Question: Summarize what this figure shows in one sentence.
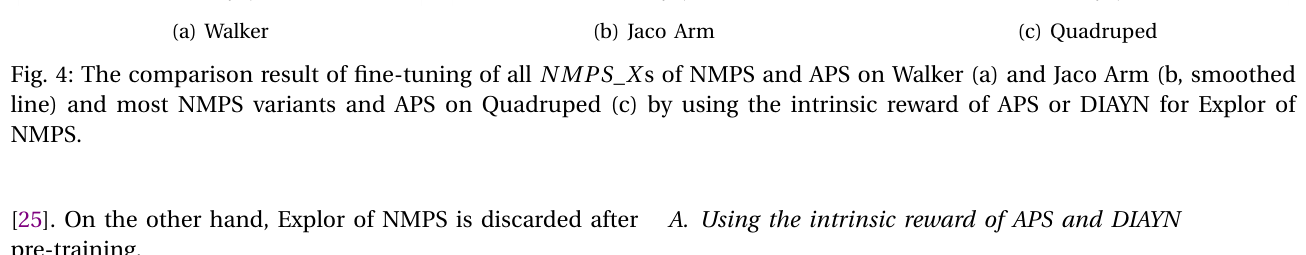
Answer: presents a comparison of the best performance achieved by NMPS, APS, DIAYN and SMM in all three domains. According to the results, DIAYN and SMM perform worse than or similarly to APS in Walker and Jaco Arm do- mains. However, in only Quadruped domain, DIAYN shows remarkable performance in the early stage. Hence, in the experiment on Quadruped domain, NMPS employs DIAYN as Explor for taking advantage of the performance of DIAYN. Overall, due to the expected effect of aforementioned four factors of NMPS, NMPS shows the best performance among all competence-based algorithms.